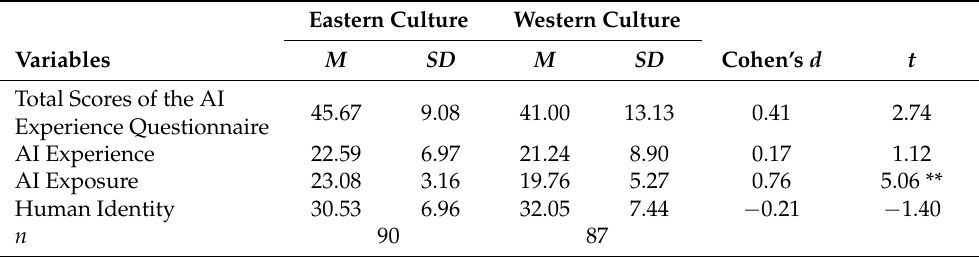
Table 7. T -test analysis of AI exposure, AI experience, and human identity, Study 3.